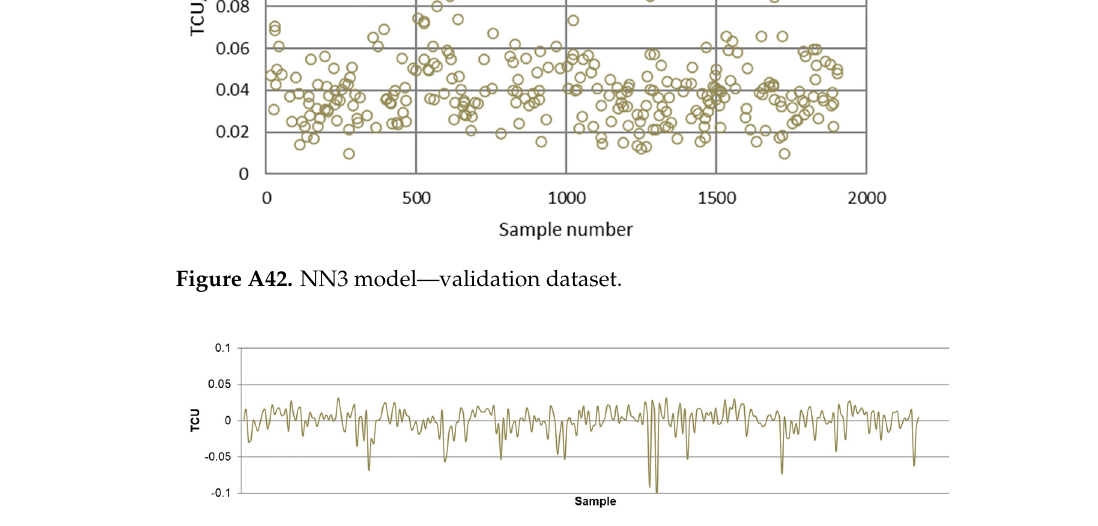
Figure A43. Prediction error of NN3 model validation dataset. Table A5. Regression statistics parameters of NN3 model datasets.